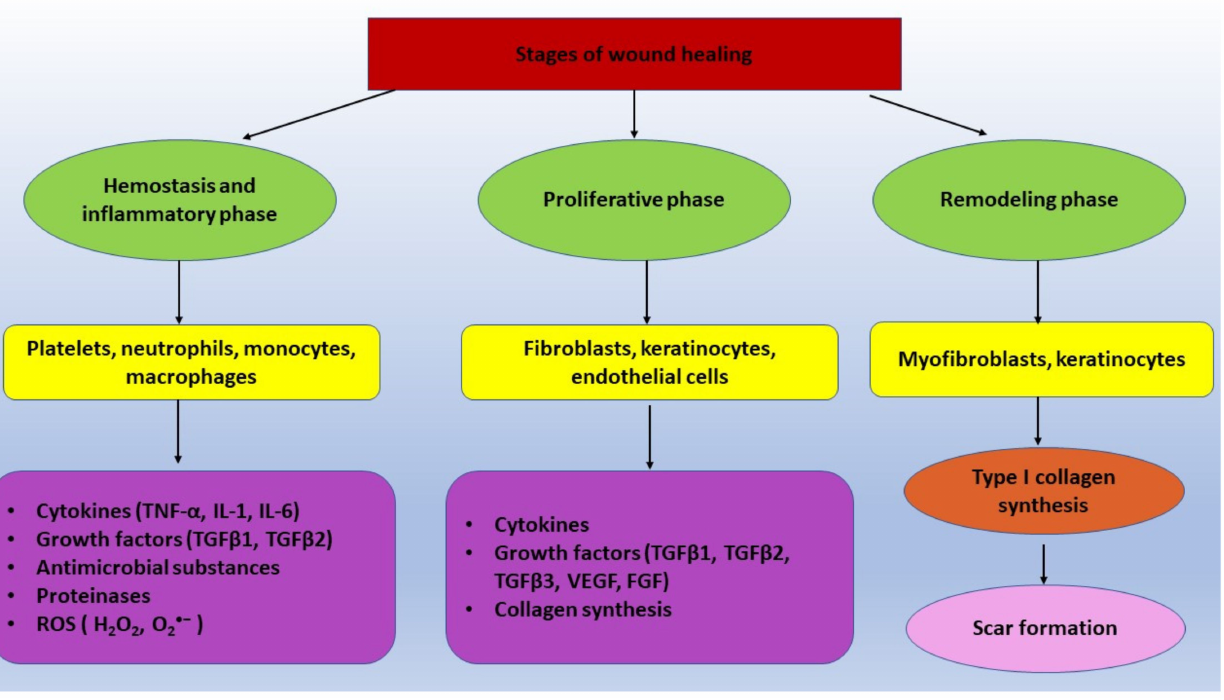
Figure 1. Stages of wound